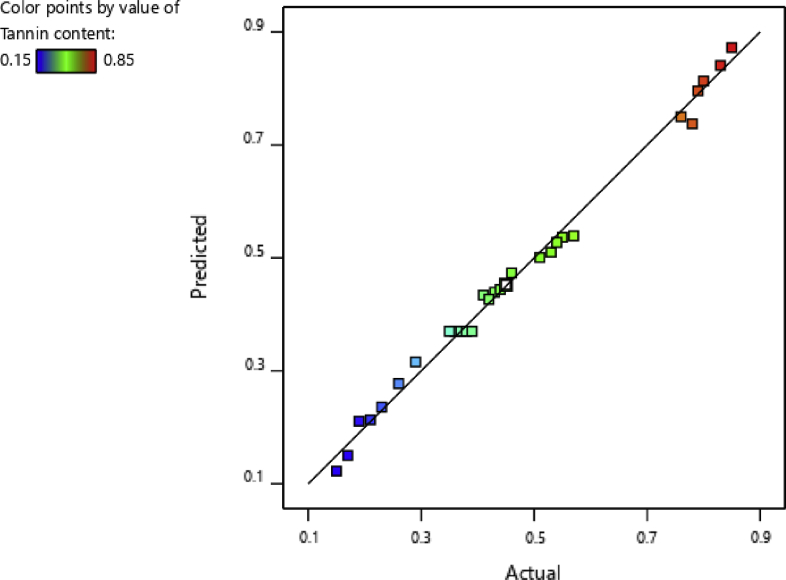
Predicted versus actual values for tannin content.